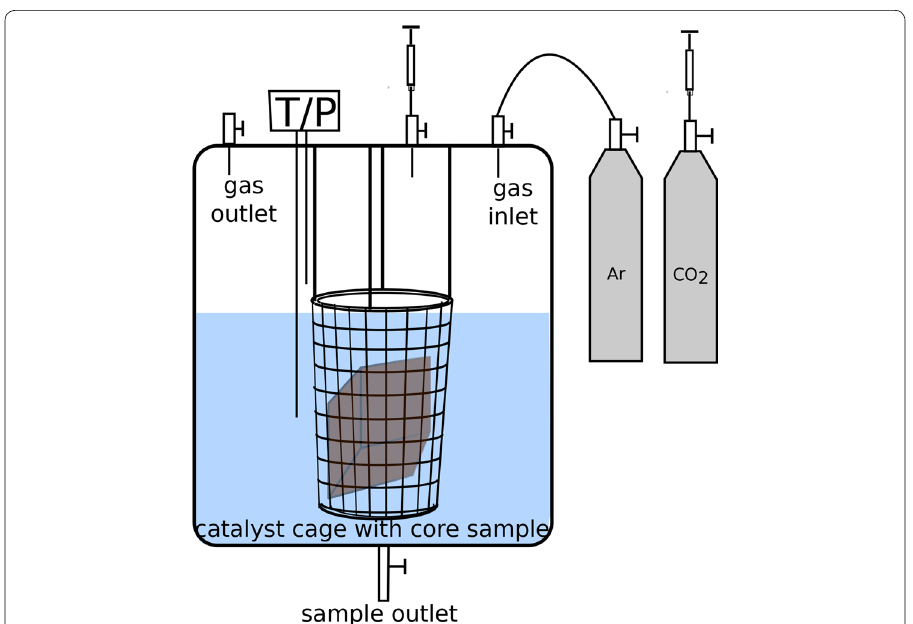
Fig. 1 Schematic overview of the autoclave experiment. The defined volume of CO 2 is injected by means of a gas